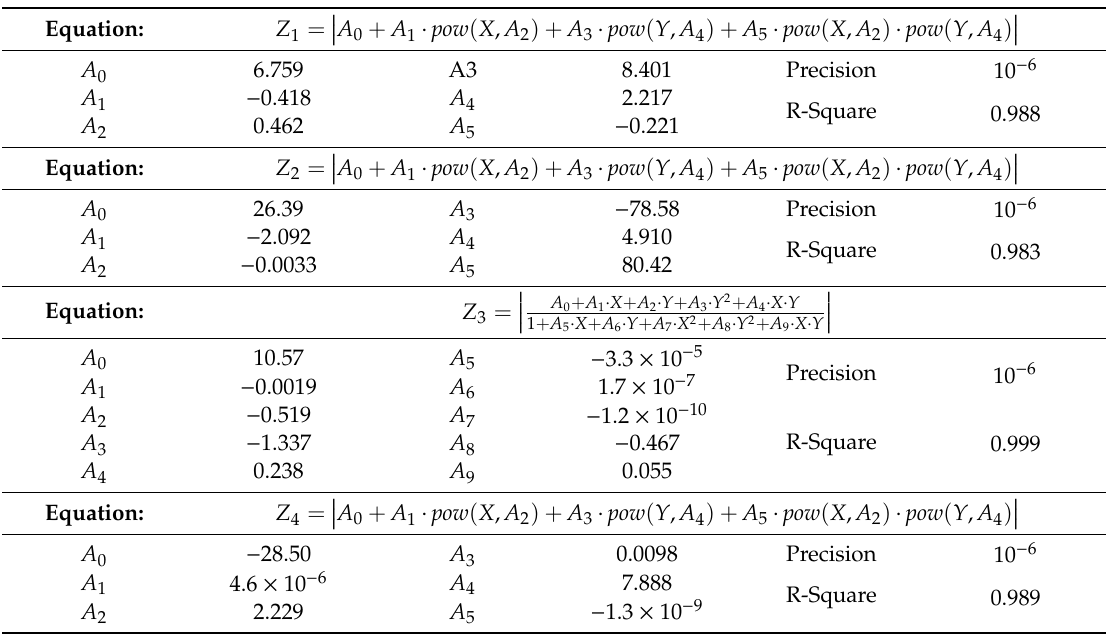
Table 4. Formula and parameters of the fitting analysis